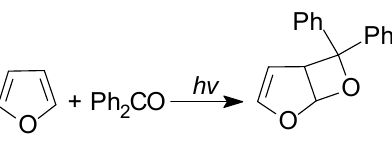
Figure 5. Structure of the biradical intermediate in the reaction of furan with benzaldehyde.